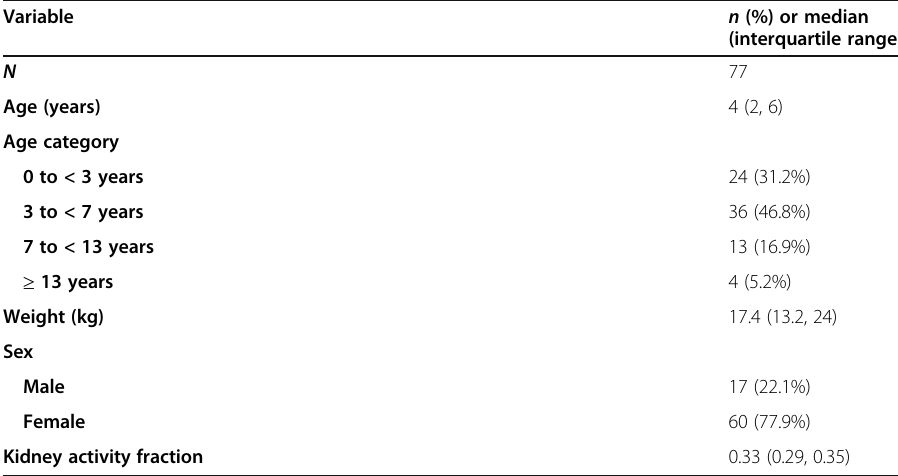
Table 2 Summary of data evaluated by regression analysis Variable